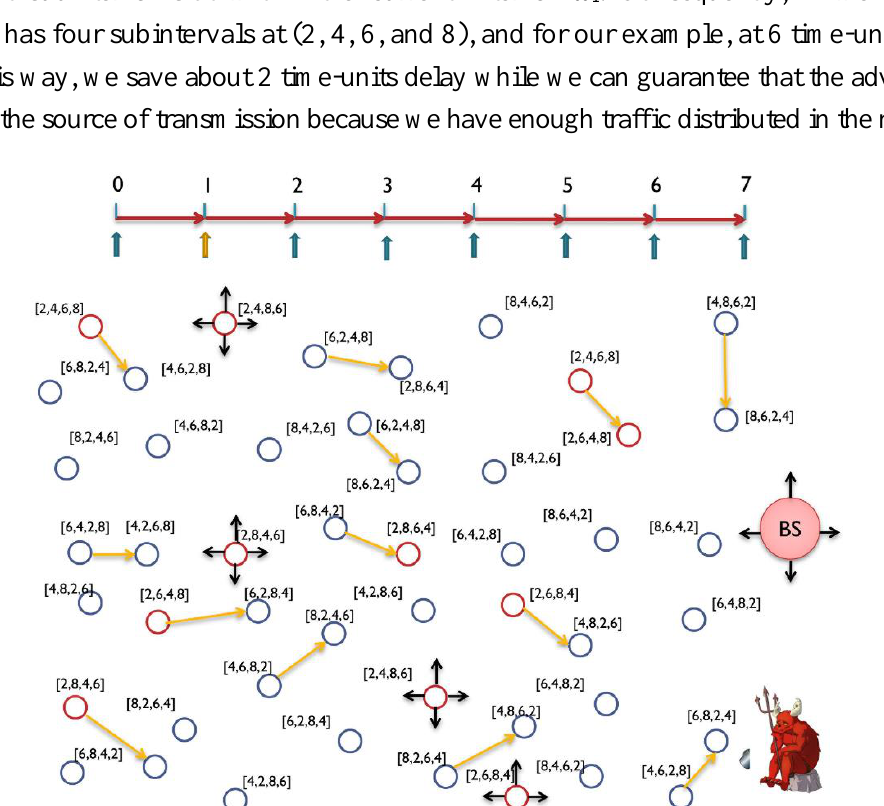
= 2 will send a fake message if it does not i